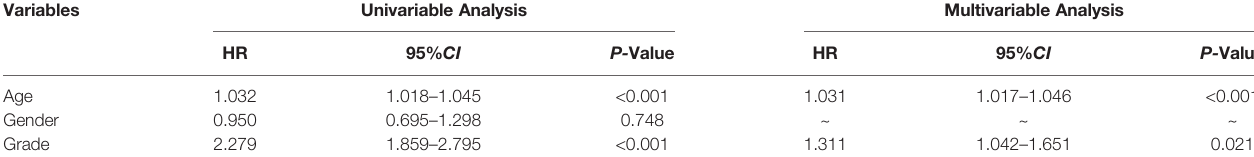
TABLE 3 | Univariable and multivariable Cox regression to analyze the relationship between the RS and clinical prognosis.